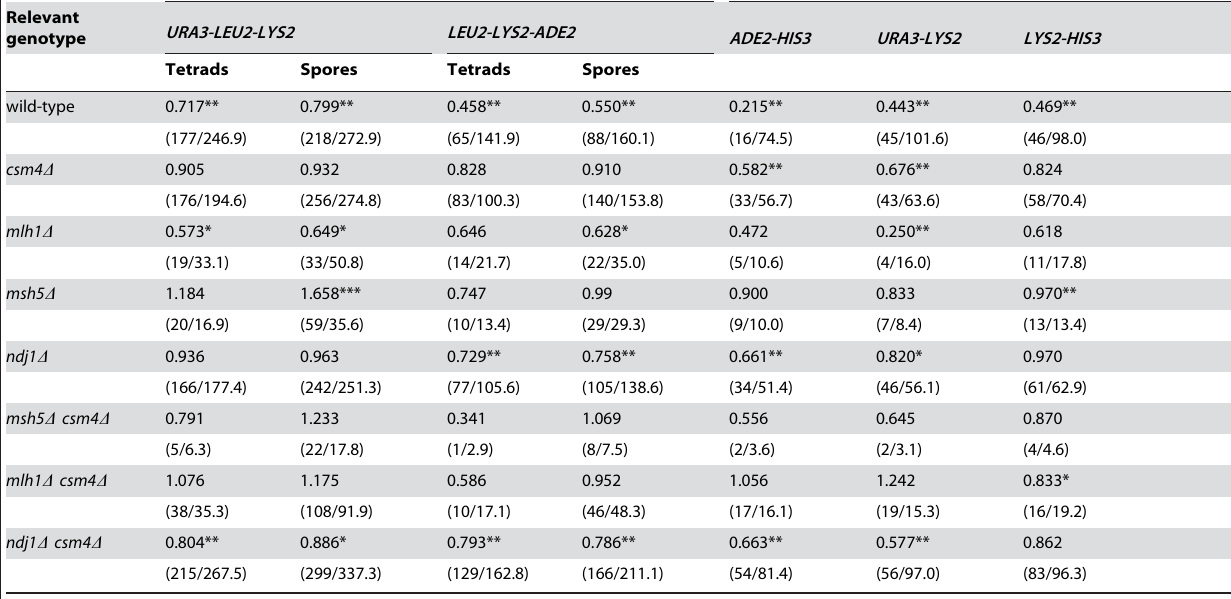
Coefficients of coincidence (DCO observed/DCO